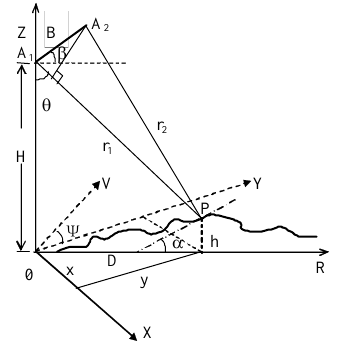
Figure 2 InSAR imaging geometry